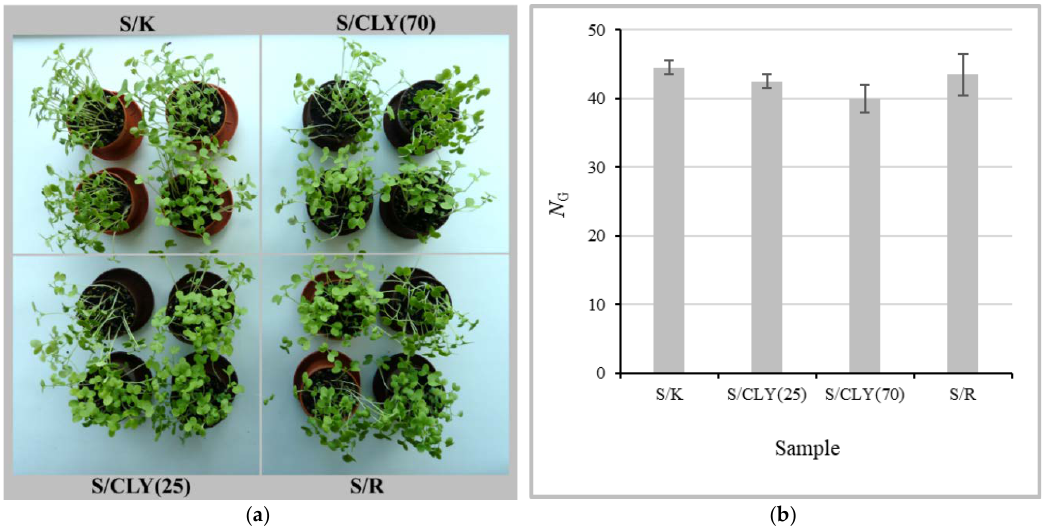
Figure 8. Growth of Sinapis arvensis sprouts in soil, which was in contact with samples K (S/K sample), CLY(25) (S/CLY(25) sample), and CLY(70) (S/CLY(70) sample) during 50 days of burial and in the reference soil (S/R sample) with no sample contact ( a ) and number, N G , of sprouts grown in the soil in 14 days ( b ).